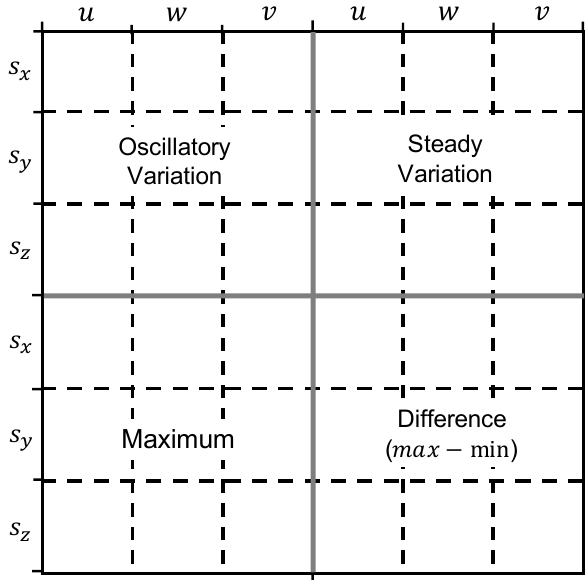
Figure 4. Canvas, quadrants,